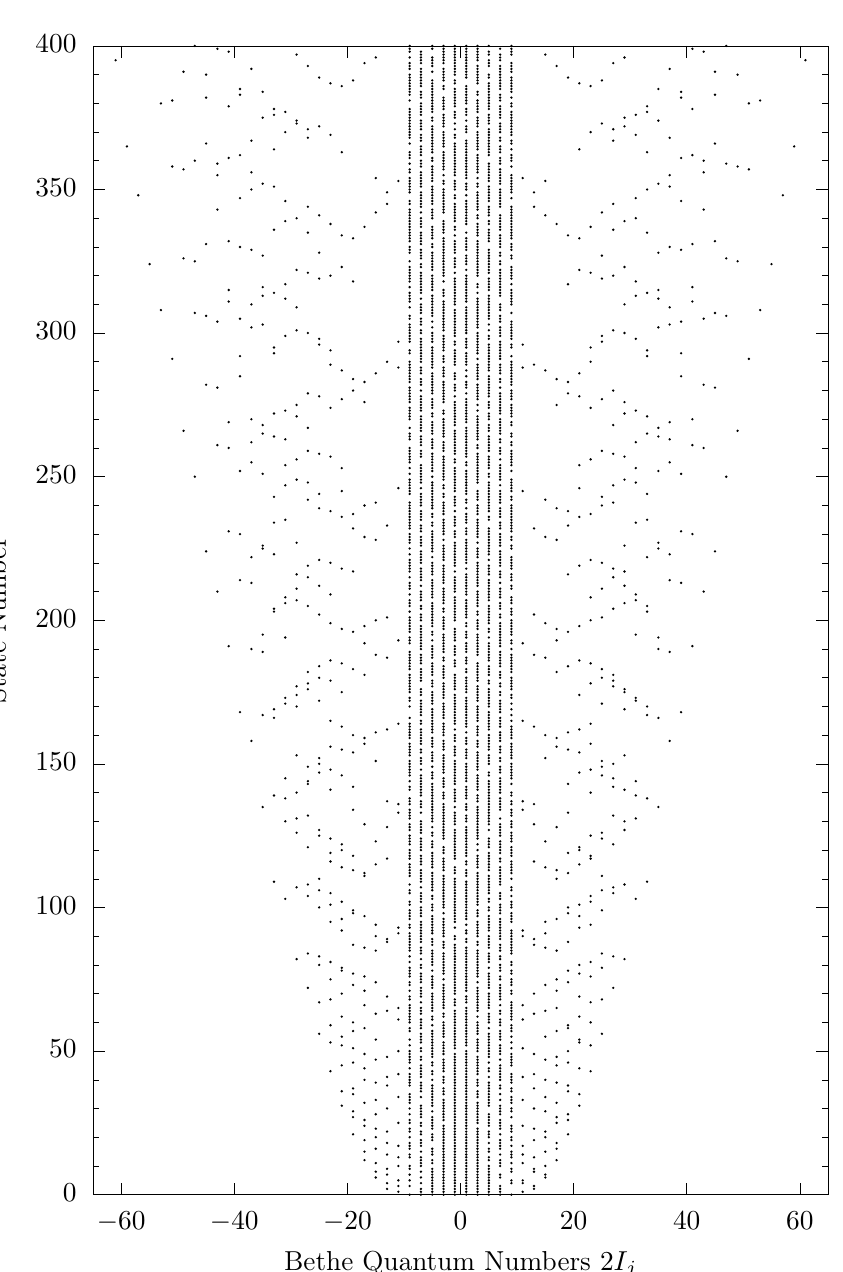
Figure 7: The configurations of integers { I erential scanning and ordered according to the metric (22) for the c quench. (Highest weights correspond to lowest state numbers.) Notice the similarity with Fig. 6, the output of the NRG-ME procedure; the preferential scanning algorithm efficiently generates those basis states with largest